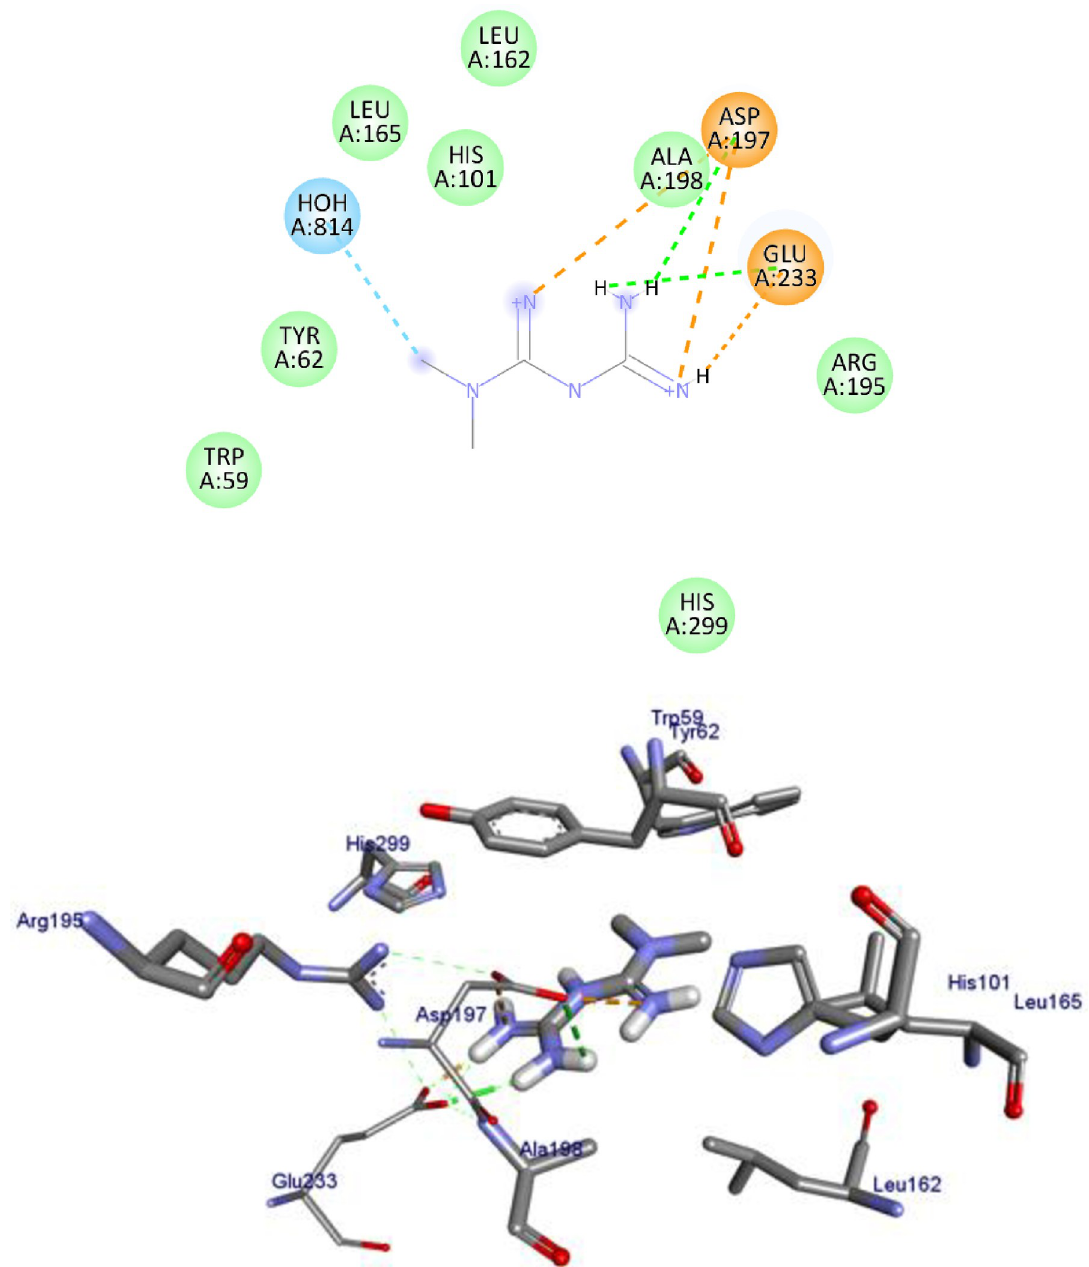
Fig 5. 2D (upper panel) and 3D (lower panel) representations of the binding modes of metformin to Human α -amylase (PDB ID: 4W93). amylase and α -glucosidase. Overall, the in-silico docking analysis indicated that apigenin ( 1) that interacts with the α -amylase residues of Tyr 62, Trp 58, His 299, Asp 300, Asn 298, Arg 195 and Ile 235 with binding energy -8.3 kcal/mol, chrysin ( 4) that interacts with the α -amy- lase residues of Trp 58, Trp 59, Tyr 62, His 299 and Gln 63 with binding energy -8.1 kcal/mol, kaempferol ( 8) that interacts with the α -amylase residues of Trp 58, Trp 59, Tyr 62, His 299, Glu 233, Asp 197, Arg 195, Ala 198, and Leu 165 with binding energy -8.1 kcal/mol, quercetin